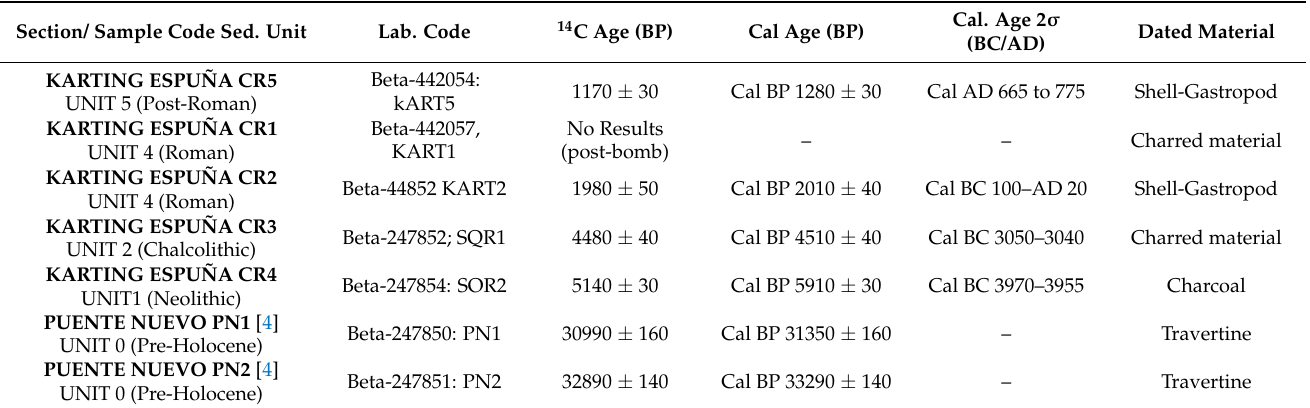
Table 3. Radiocarbon data for the Holocene filling of the Guadalent í n Depression obtained for this study in the Karting Espuña Section. Data also include ages obtained for pre-Holocene travertines preliminary reported by Calmel- Á vila et al., 2009